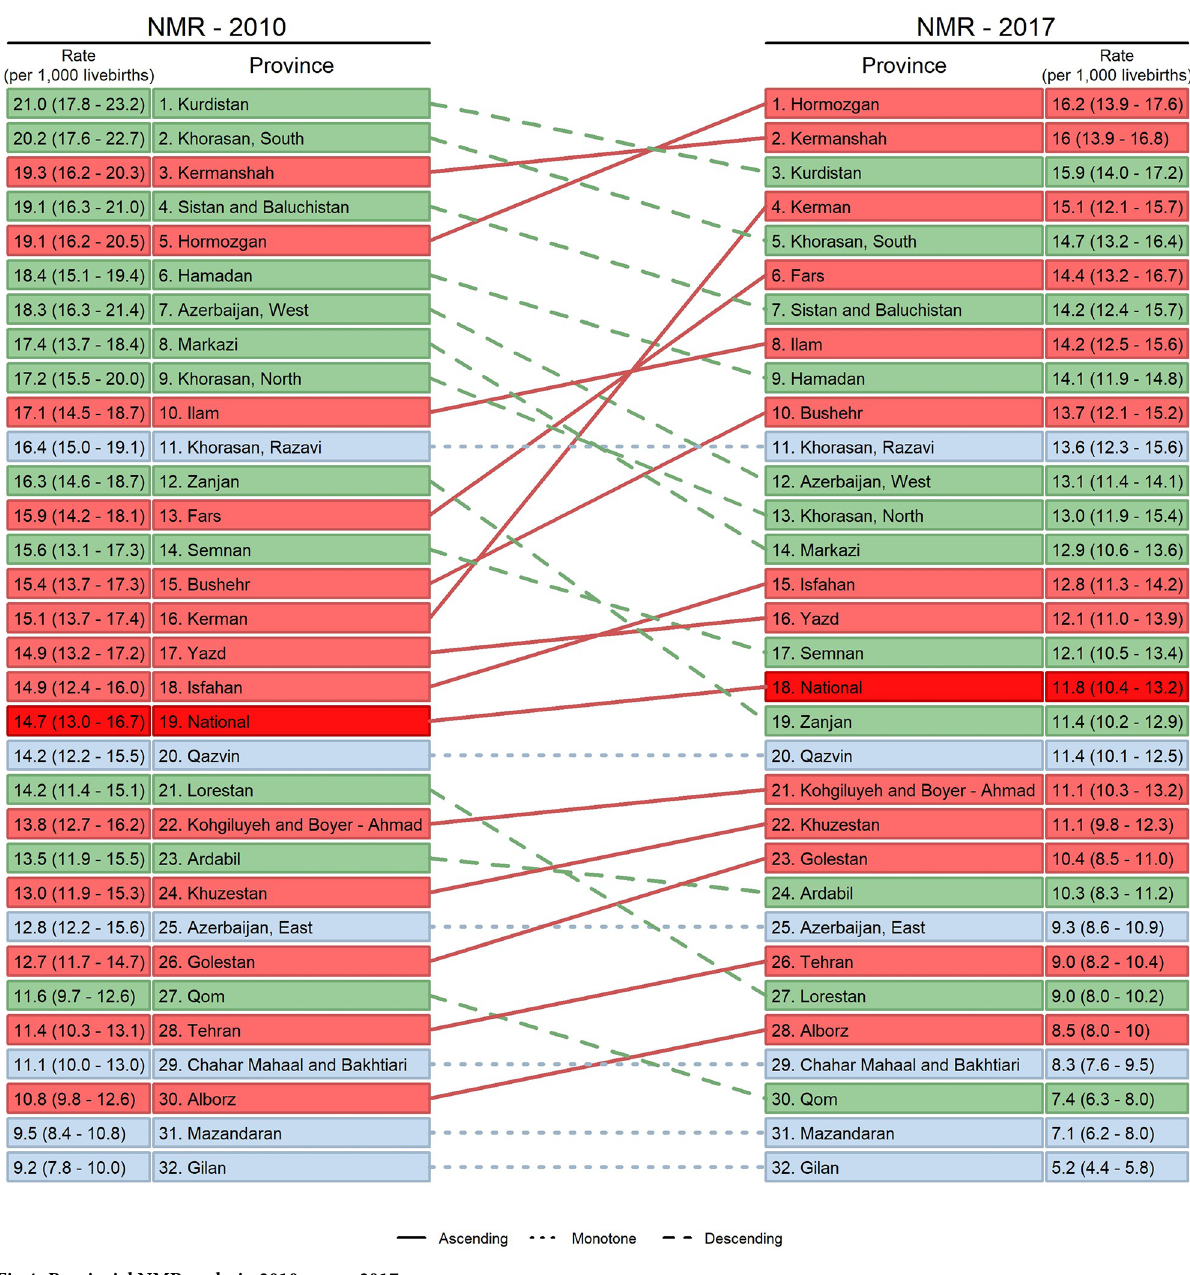
The neonatal proportion of U5MR in Iran was 67 � 8% (95%CI 56 � 8%-81 � 3%) in 2010, and rose to 77 � 7% (95%CI 62 � 6%-97 � 4%) in 2017. This proportion was above 70% in all provinces in 2017, ranging from 70 � 1% (95%CI 60 � 3%-91 � 8%) to 89 � 1% (95%CI 63 � 4%-100 � 0%). All prov- inces showed an increasing trend in this proportion, except for Gilan and Lorestan, which remained almost stable. However, these changes were not statistically significant. A remark- able increase was observed in Kerman’s proportion, from 67 � 2% (95%CI 57 � 4%-77 � 7%) to